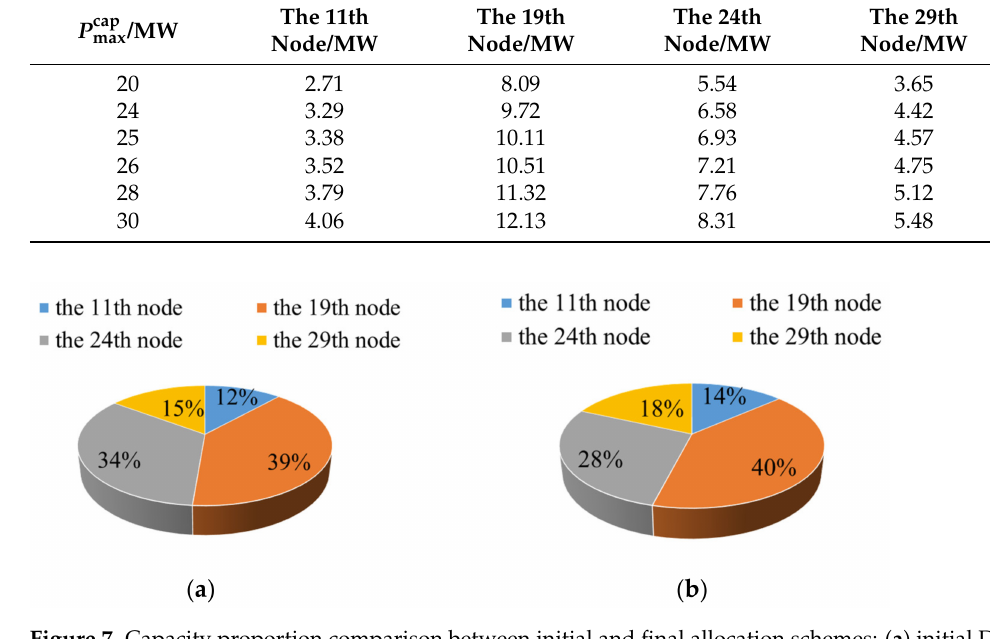
Figure 7. Capacity proportion comparison between initial and final allocation schemes: ( a ) initial DG capacity proportion; ( b ) final DG capacity proportion.